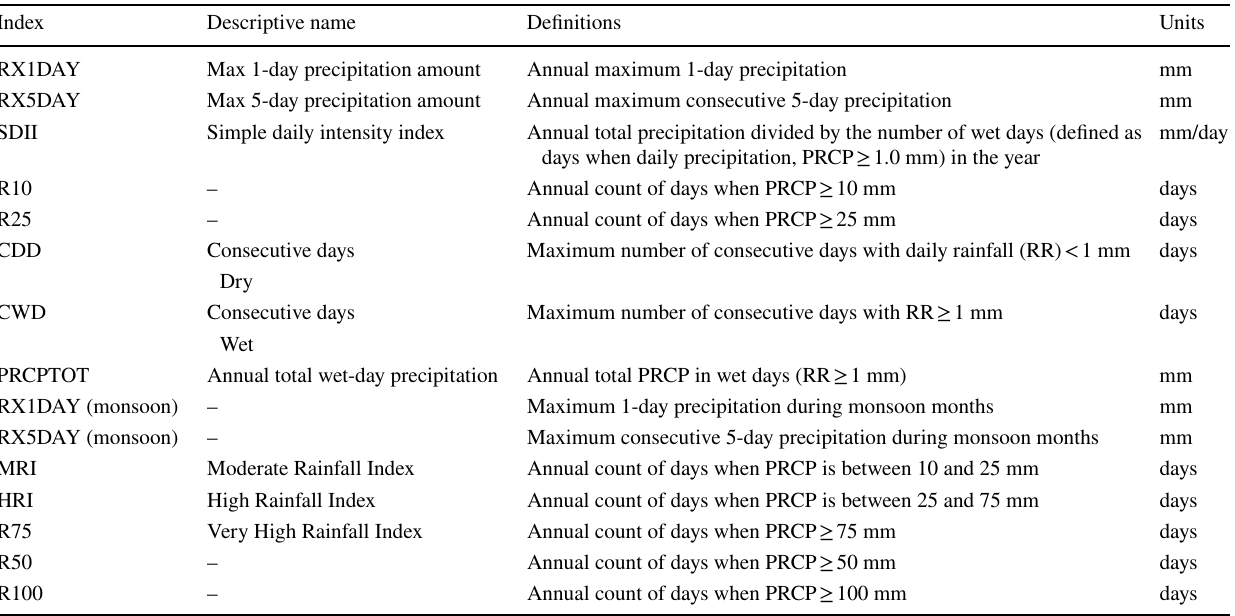
Table 1 Extreme precipitation indices determined in the